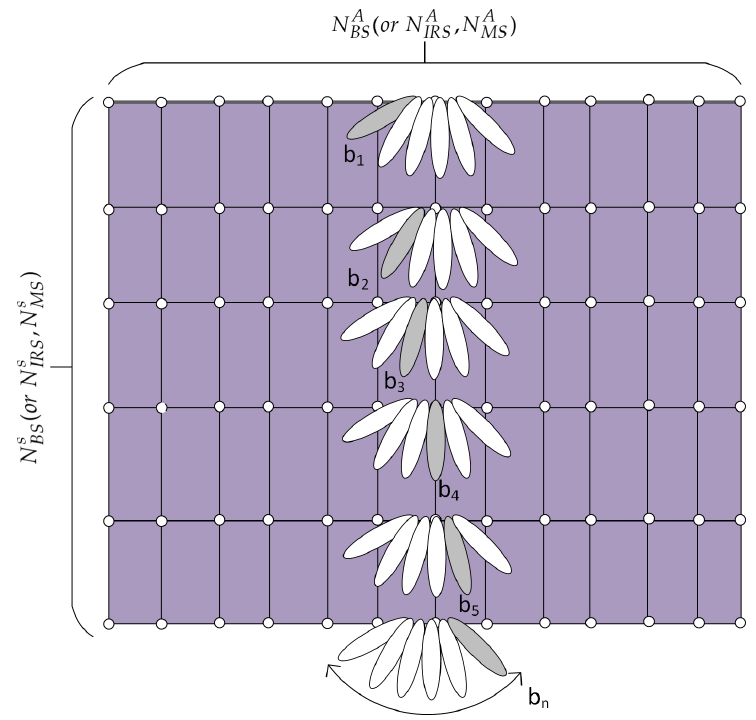
Figure 2. Uniform rectangular arrays at the BS, IRS, and